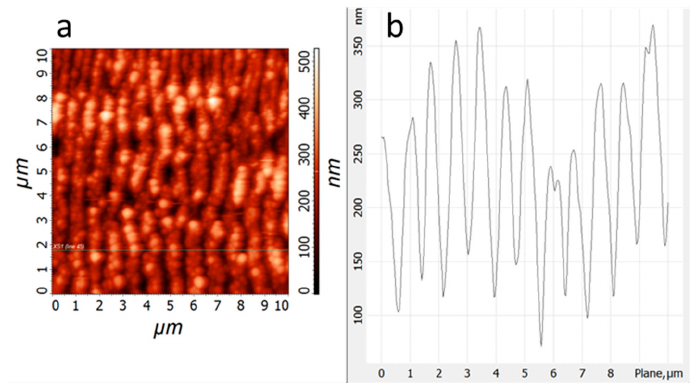
Figure 2. Atomic Force Micrpscopy (AFM) image ( a ) and surface profile ( b ) for laser-treated Figure2. AtomicForceMicrpscopy(AFM)image( a )andsurfaceprofile( b )forlaser-treated15 × (Ti / Zr) / Si 15×(Ti/Zr)/Si multilayer thin film at fluence of 0.662 Jcm − 2 . multilayer thin film at fluence of 0.662 Jcm − 2 .